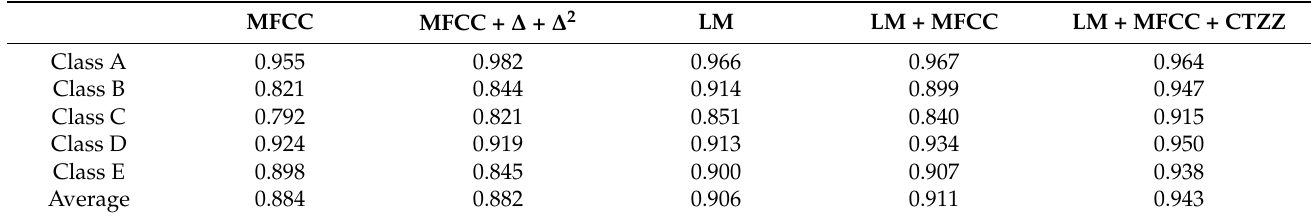
Table 3. The comparison of different feature extraction methods with